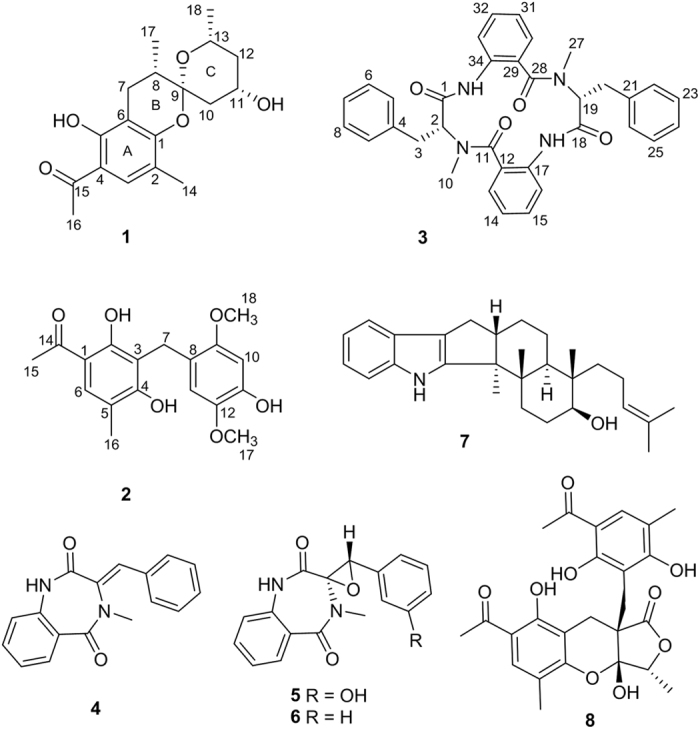
Structures of 1–8.